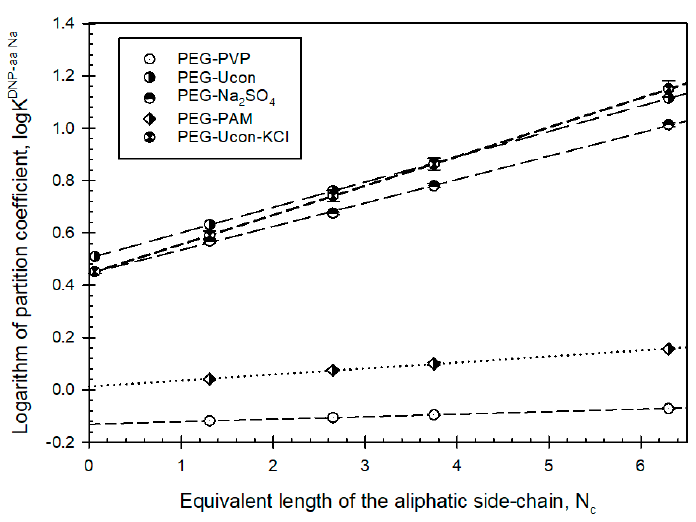
Table 1. Solvent properties of studied aqueous two-phase systems.